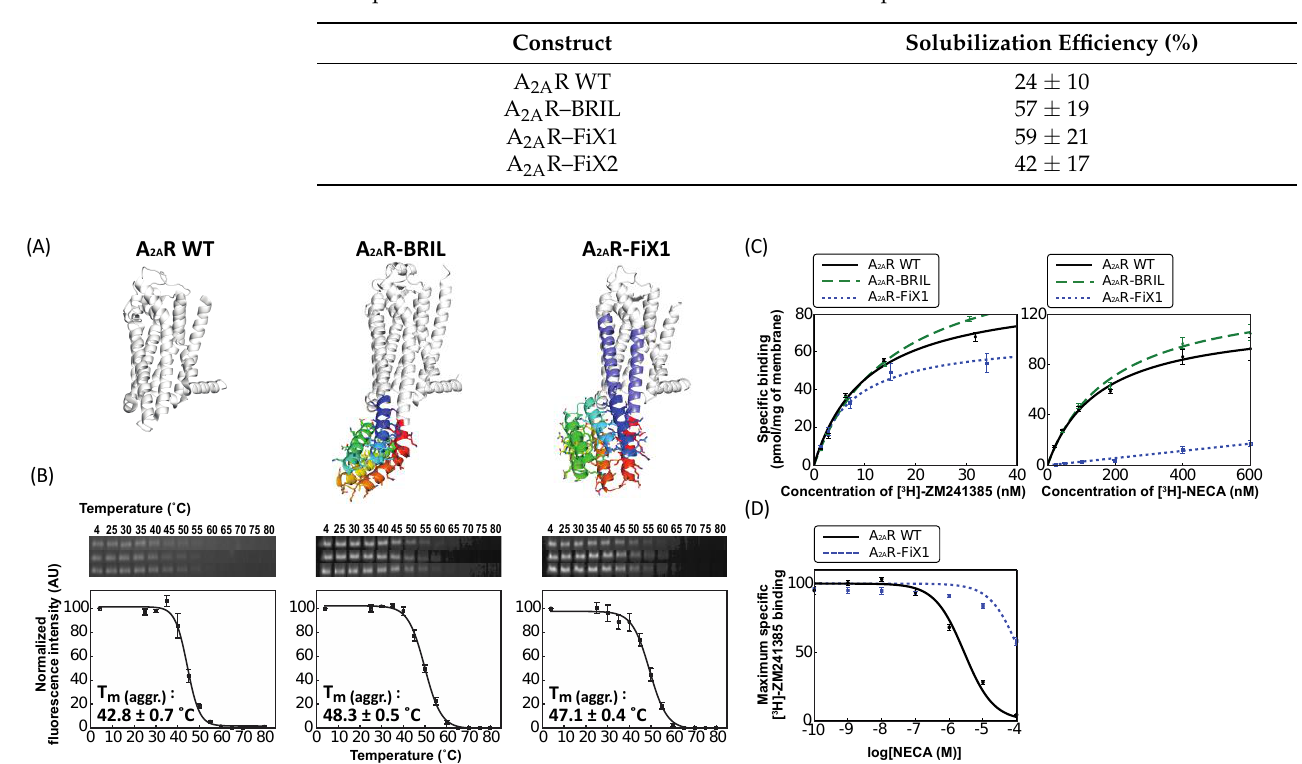
Figure 4. Experimental characteristics of A 2A R fused with or without fusion partner proteins. ( A ) Crystal structures of A 2A R WT (PDB ID: 3VG9) [22], A 2A R – BRIL (PDB ID: 4EIY) [12], and the computational model of A 2A R – FiX1. ( B ) (Top) Monomer bands in the clear-native PAGE for each A 2A R sample heated at various temperatures. (Bottom) The fluorescence intensities of the gel images for each A 2A R sample with temperature. The thermal transition from soluble to aggregated states was fitted (solid line) to obtain the midpoint temperature, Tm (aggr.) ( C ) Saturation binding curves of [ 3 H]-ZM241385 (left) and [ 3 H]-NECA (right) to A 2A R WT (solid line), A 2A R – BRIL (dashed line), and A 2A R – FiX1 (dotted line). ( D ) Inhibition of [ 3 H]-ZM241385 binding to A 2A R WT (solid line) and A 2A R – FiX1 (dotted line) by NECA. The binding of [ 3 H]-ZM241385 in the absence of NECA was set to 100%. All measurements were carried out three times independently; dots show the average and whiskers show the s.e.m. for n = 3.